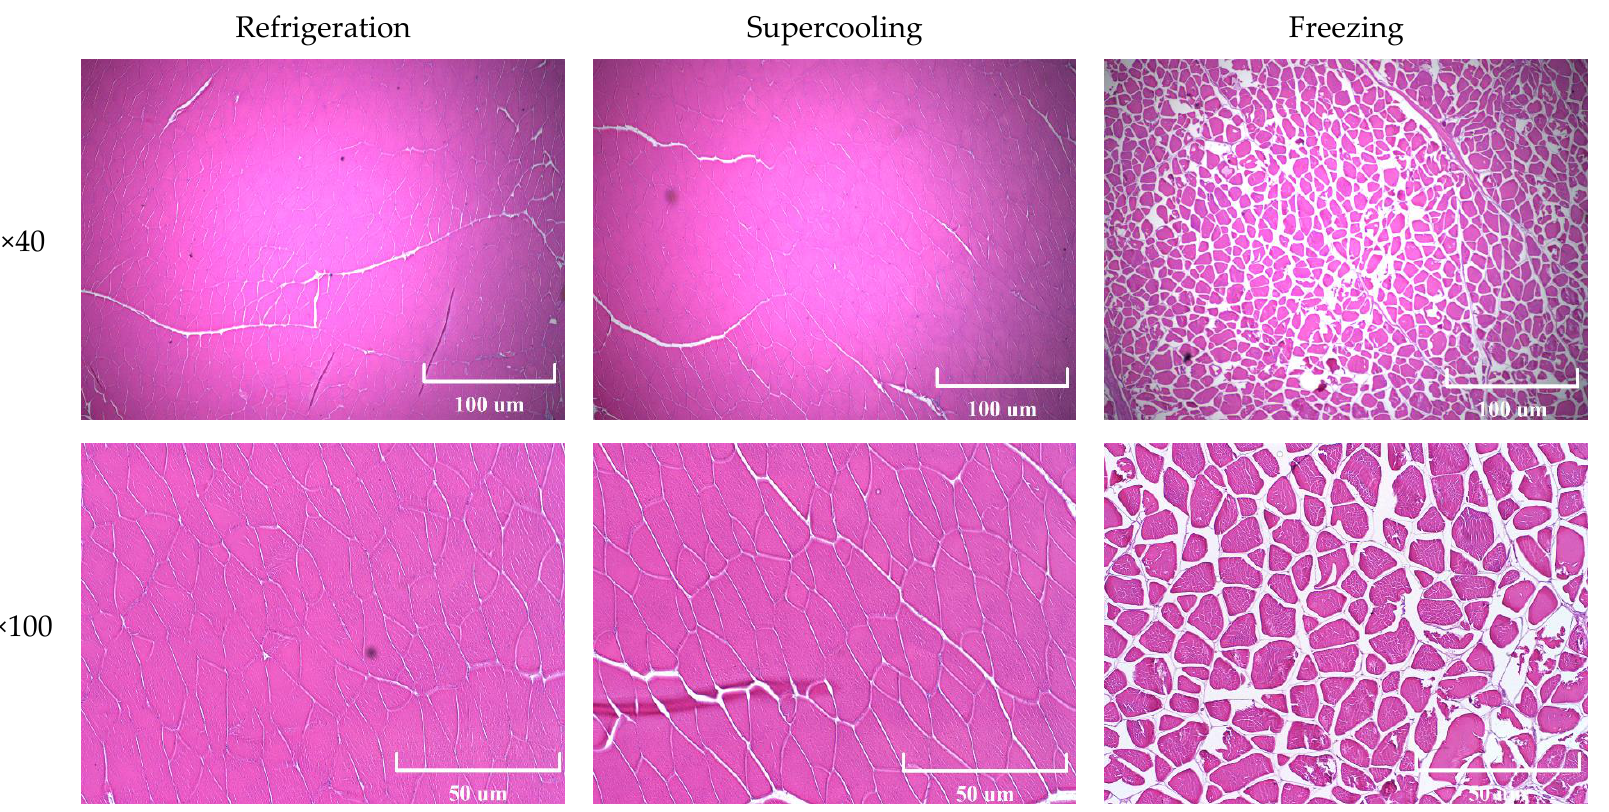
Figure 4. Optical microscopy images with different magnifications (×40 and ×100) of refrigerated, supercooled, and frozen-thawed samples.